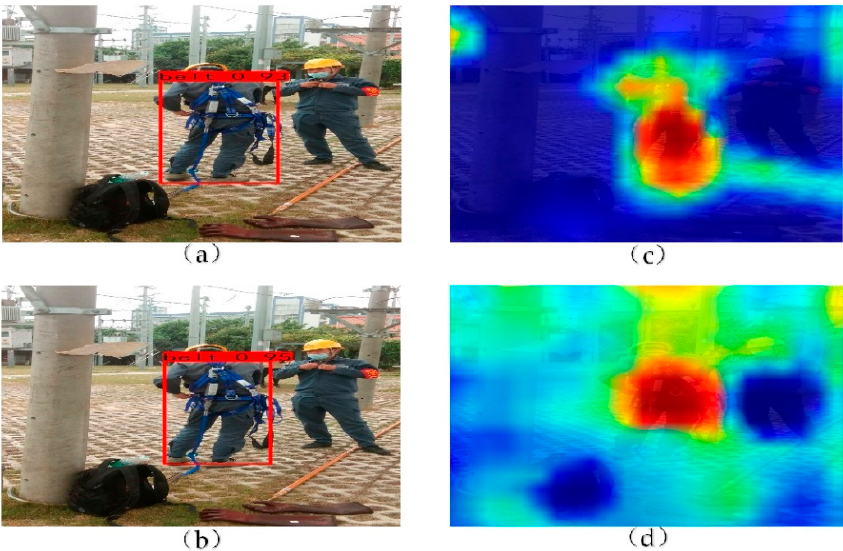
Figure 5. Results of correctly predicted samples: ( a ) prediction of YOLOv4-tiny; ( b ) prediction of YOLO-DFAN; ( c ) heatmap of YOLOv4-tiny; ( d ) heatmap of YOLO-DFAN.